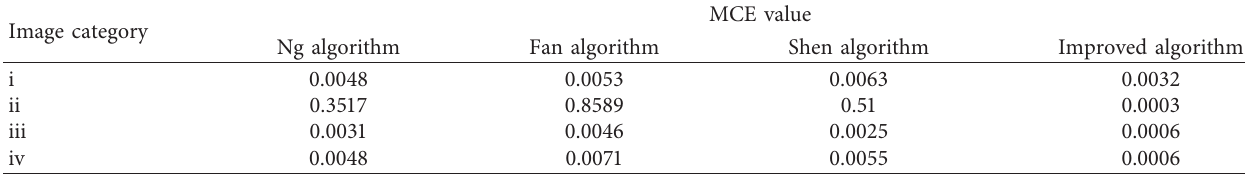
Table 1: MCE value of the vibration image under each threshold segmentation algorithm. Image category Ng algorithm Fan algorithm Shen algorithm Improved